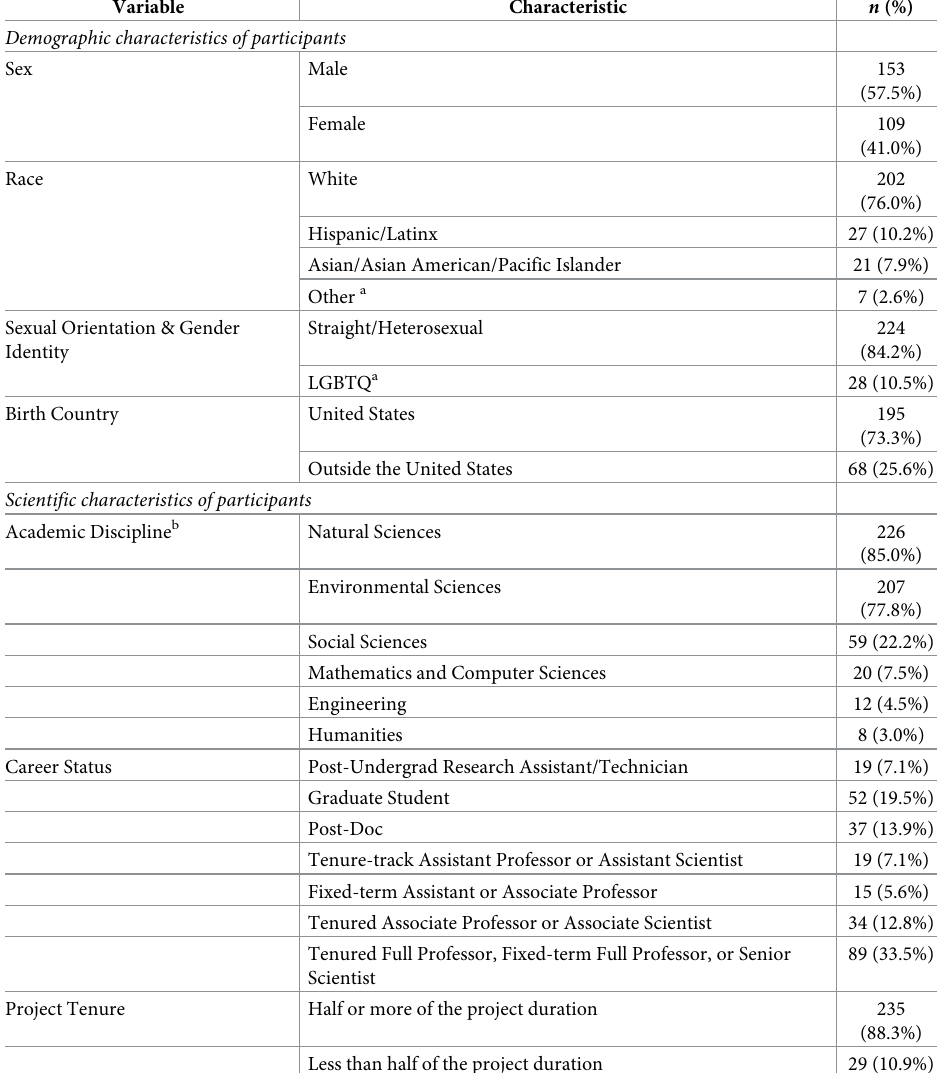
Table 1. Demographic and scientific characteristics of survey